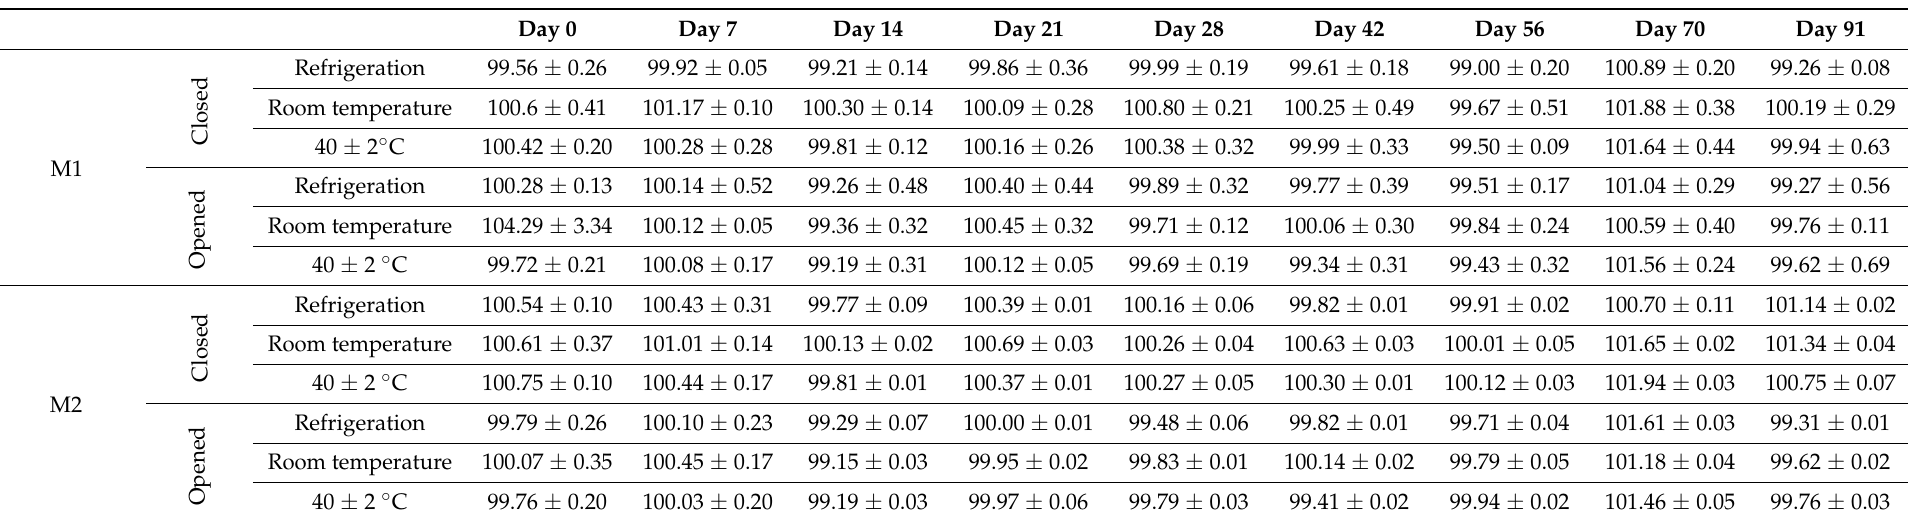
Table 2. Percentage of recovery of both methadone hydrochloride oral